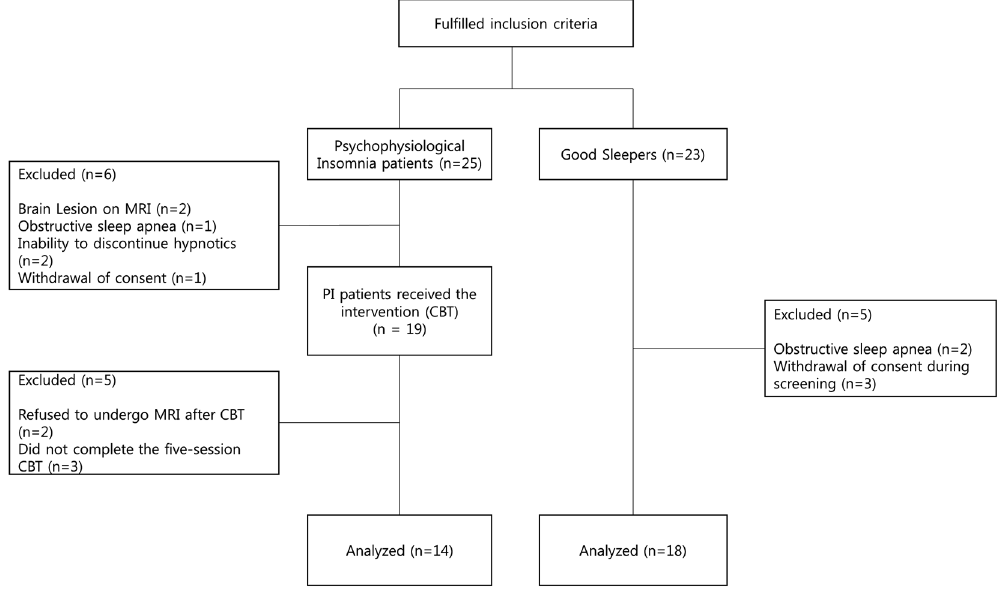
Figure 1. Diagram of the study flow of PI patients and GS. Abbreviations: PI: psychophysiological insomnia, GS: good sleepers.